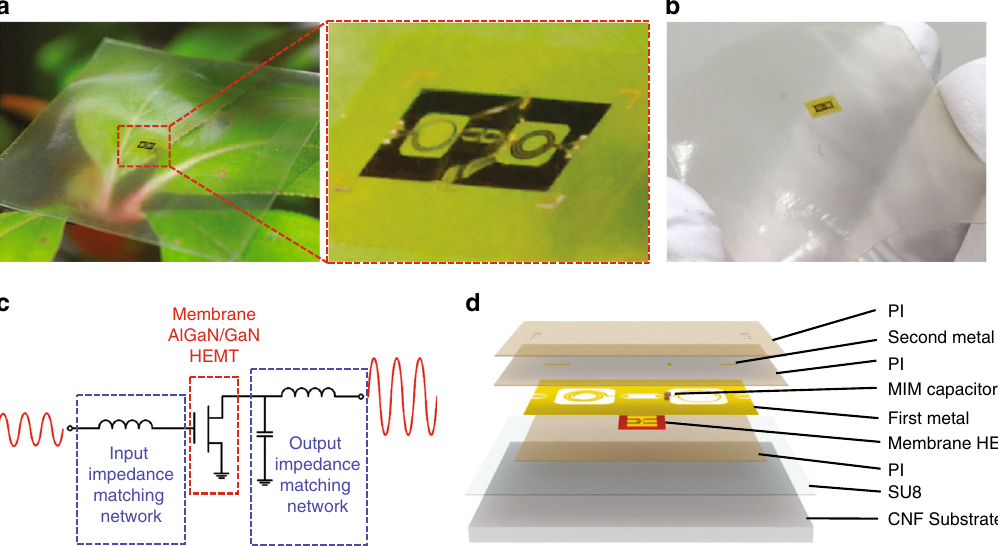
Fig. 2 An f MIC ampli fi er on a CNF substrate. a A photograph of a fabricated f MIC ampli fi er on CNF substrate placed on a leaf. The magni fi ed view shows image of the ampli fi er. b A photograph of fl exible microwave ampli fi er under bent condition. c Schematic circuit diagram of the ampli fi er with denoted function of each part. d Exploded schematic layer view of f MIC ampli fi er on CNF